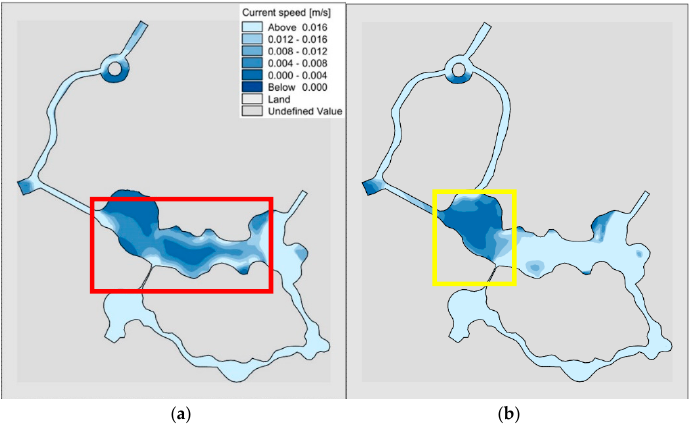
Figure 14. Comparison of flow field in “unilateral” and “bilateral” rivers under sluice diversion conditions. ( a ) “unilateral” river; ( b ) “bilateral” rivers.